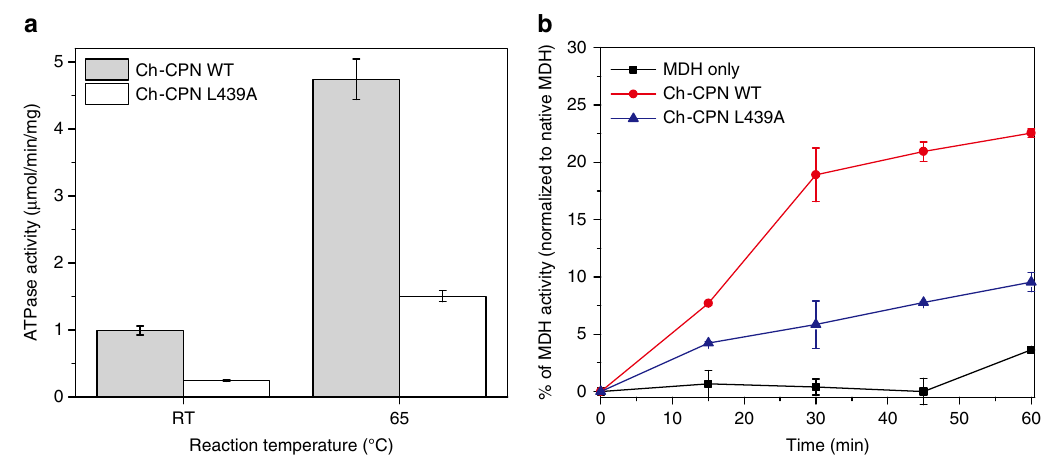
Fig. 6 Comparison of ATPase and protein folding activity between Ch-CPN WT and the pivot joint mutant (L439A). Error bars are ± s.d. for triplicate experiments. a ATP hydrolysis rates of Ch-CPN compared with the L439A mutant. ATPase activities of Ch-CPN and the L439A mutant were determined after incubation for 5 min at the indicated temperature by using the malachite green assay. b Refolding of Malate Dehydrogenase (MDH) by Ch-CPN wild type and the L439A mutant. Denatured MDH was mixed with Ch-CPN and the L439A mutant at 42 °C, respectively. The speci fi c activity of MDH prior to denaturation was the control used to determine